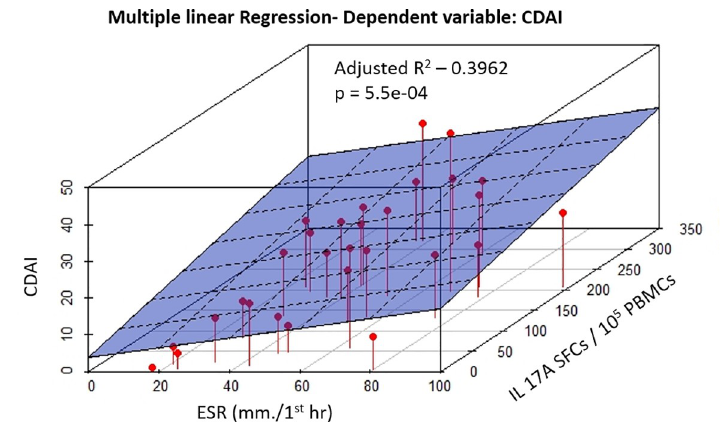
Fig 4. 3D linear regression plot visualizes correlations between the CDAI, ESR and IL17A.